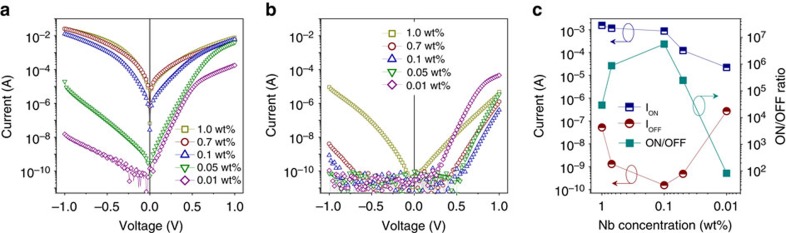
Tunnelling electroresistance of Pt/BaTiO3 (BTO)/Nb:SrTiO3 ferroelectric tunnel junctions with a 4 u.c.-thick BTO barrier as a function of Nb concentration.(a,b) I–V curves for the ON and the OFF state, respectively. (c) Junction currents and ON/OFF ratios, read at 0.6 V.